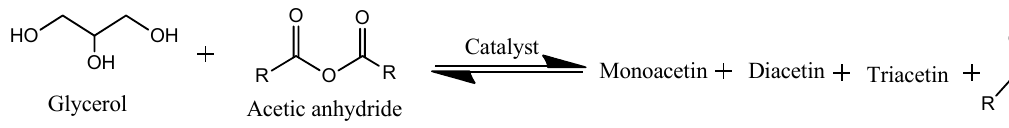
Scheme 5. Conversion of glycerol to acetin by acetylation with acetic